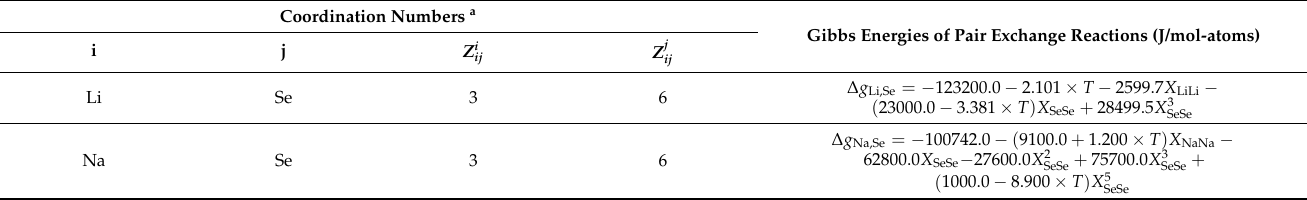
Table 3. Optimized model parameters of the liquid phase with MQMPA in the Li-Se and Na-Se binary systems.